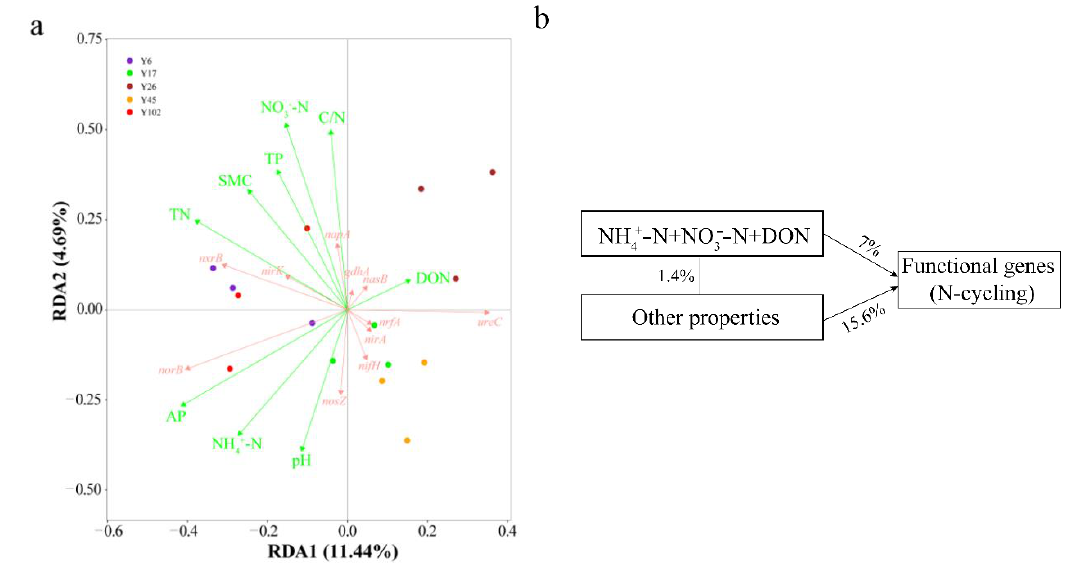
Figure 6. Redundancy analysis (RDA) ordination plots of soil properties and abundance of genes